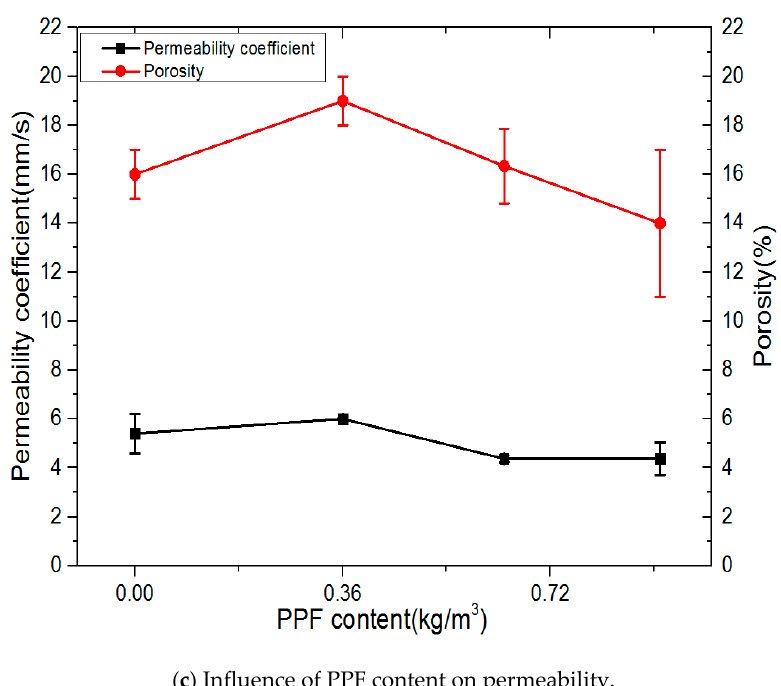
Figure 6. Influence of fiber type and content on permeability of pervious concrete.